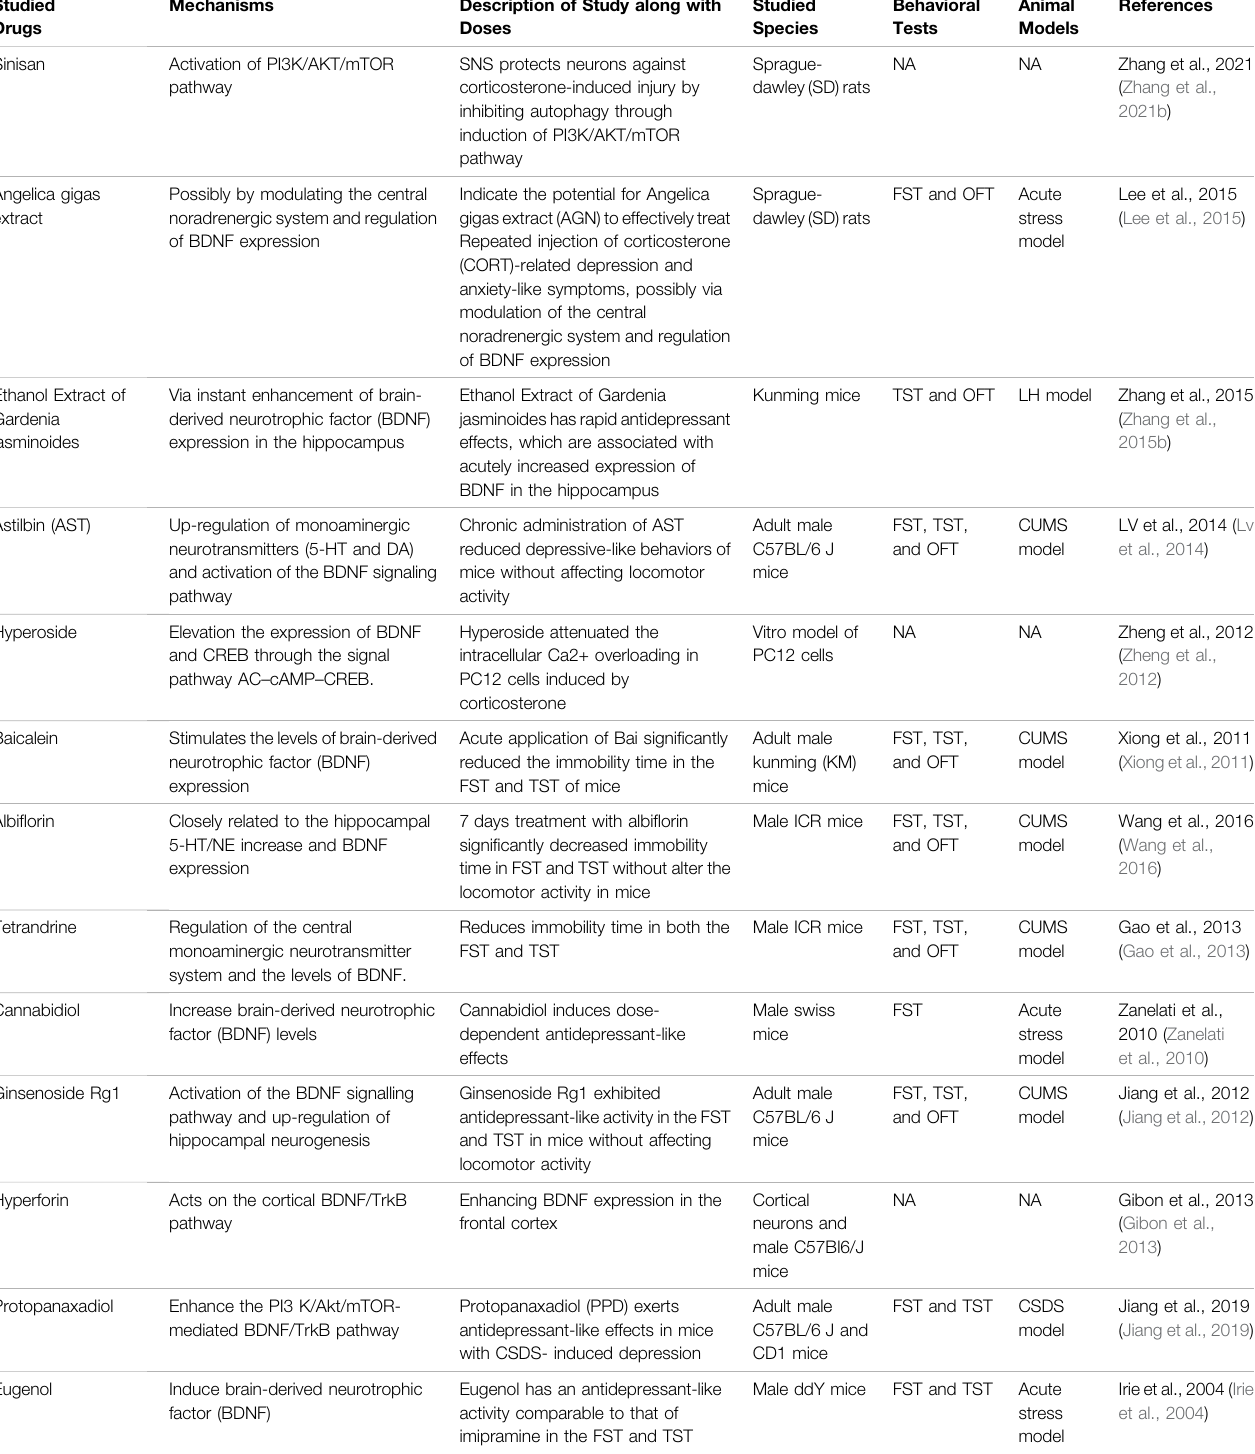
TABLE 3 | Potential natural products for the treatment of PSD by modulating the central neuroplasticity. Studied